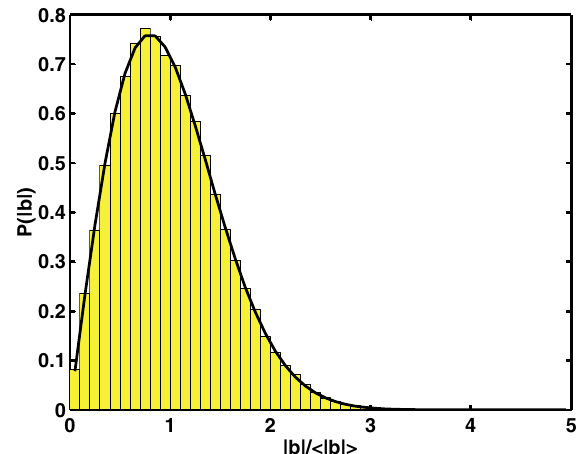
FIG. 1. (Color) The probability distribution P (cid:6)j b j(cid:7) for the ensemble of 10 5 macroparticle distributions as a histogram. The solid line is the Rayleigh distribution function of mean equal to